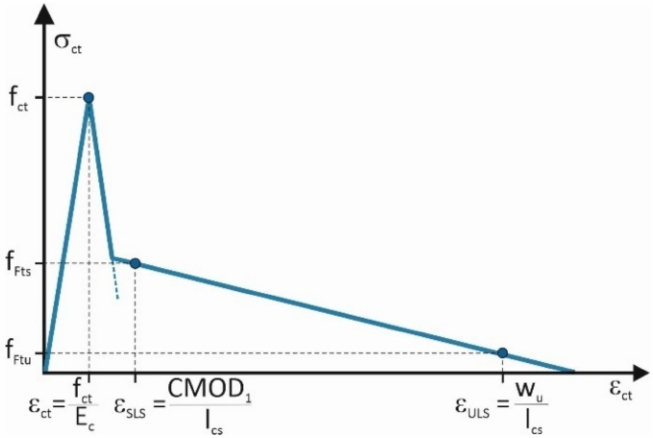
Figure 9. Material model for fiber reinforced concrete (FRC) according to MC2010.